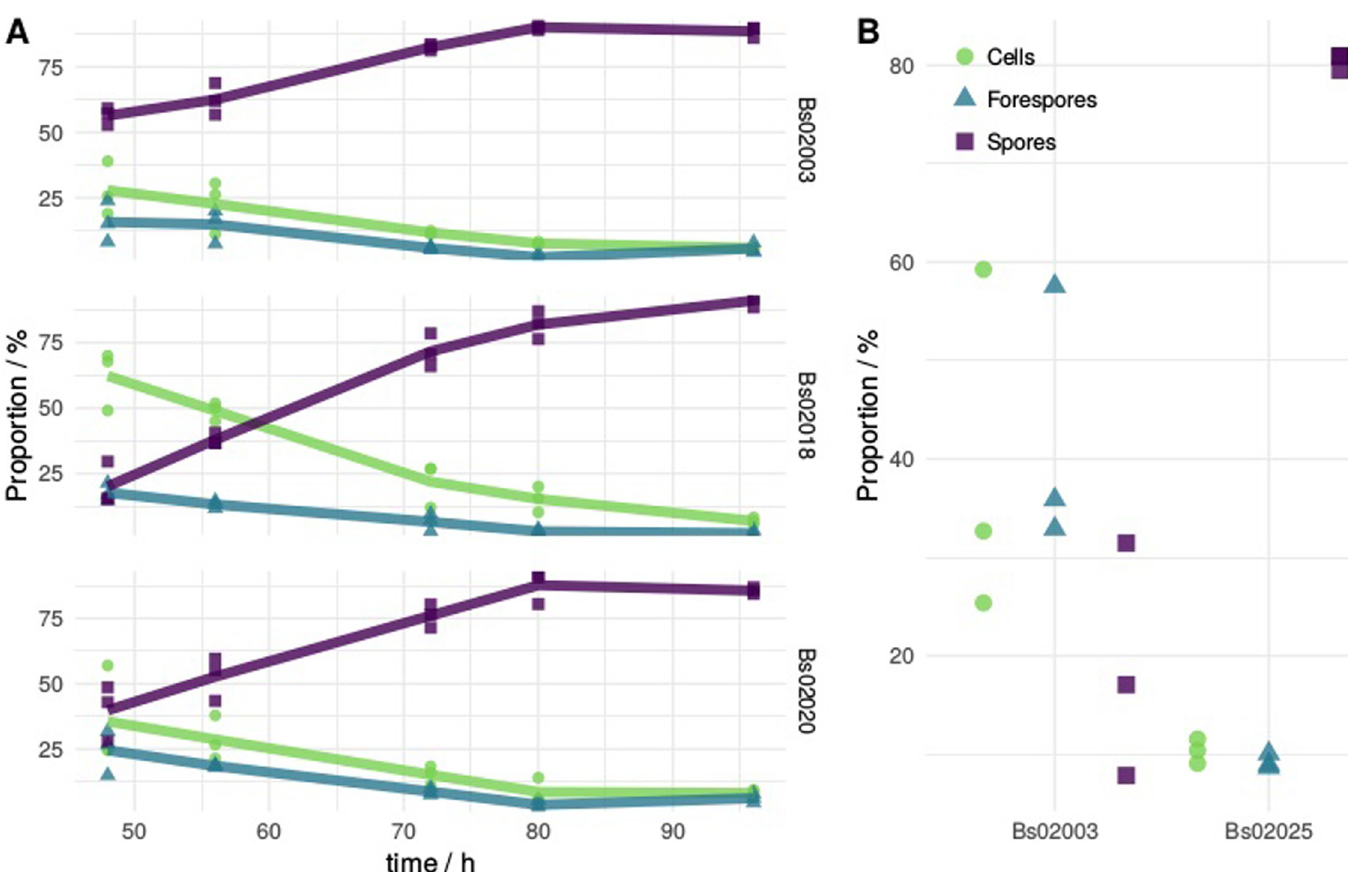
Fig 4. Analysis of sporulation dynamics of B . subtilis strains harboring different genome modifications. (A) Shift of culture subpopulations containing cells, endospores and spores over time. S trains Bs02003, Bs02018 and Bs02020 are double mutants for cwlD [24] and sleB [25] whereas strain Bs02018 additionally expresses sfGFP as a fusion protein utilized for spore surface display. Strain Bs02020 additionally harbors deletion of cotA [29]. (B) Comparison of culture subpopulations of two B . subtilis mutants after 24 hours of cultivation. Strain Bs02025 contains deletions of cwlD [24] and sleB [25] and additionally harbors deletions of spo0E [31] and skfA [30] whereas Bs02003 serves as control.